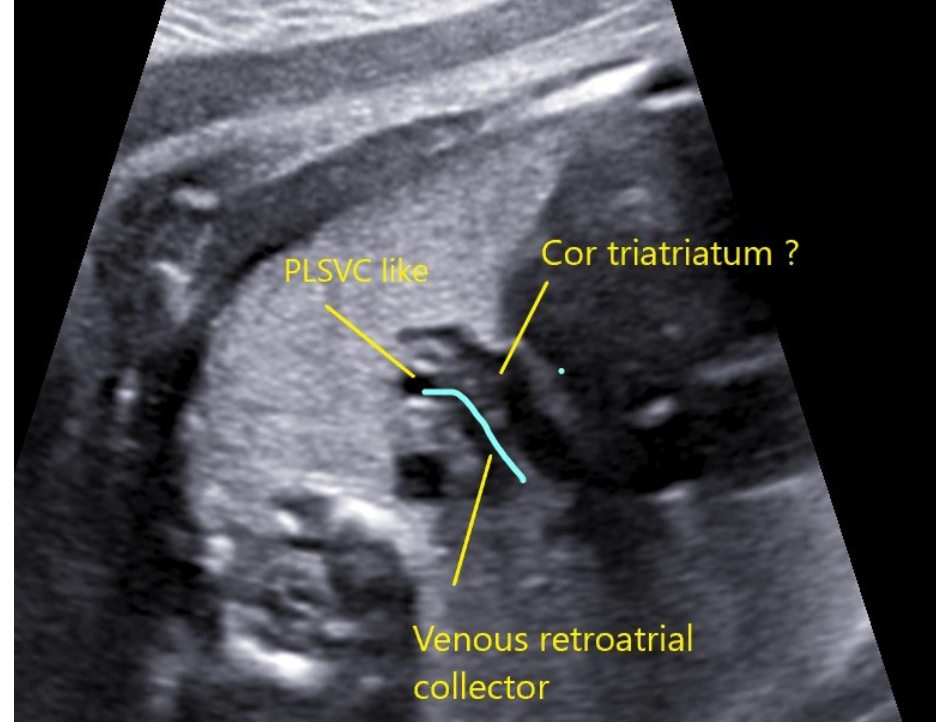
Figure 16. The same case as above; venous ascendant collector behind the left atrium and PLSCV (per- sistent left superior vena cava).